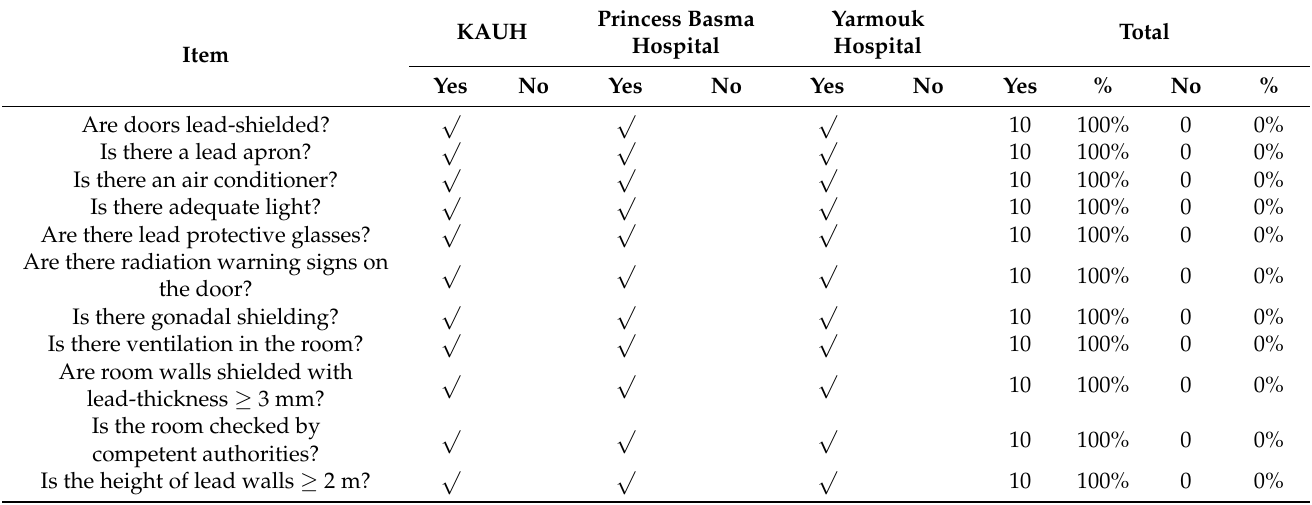
Table 7. Checklist for occupational health safety (OHS) of CT at public hospitals. (No. of samples = 10).